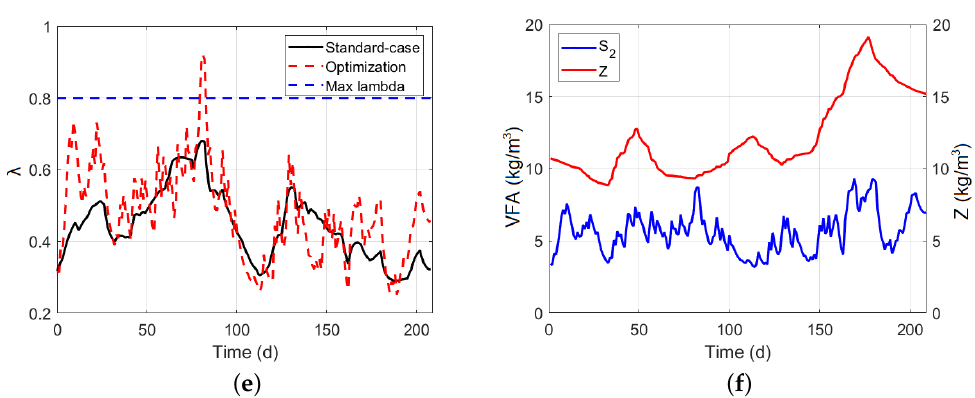
Figure 8. MPC controller without restrictions. ( a ) Volume of CH 4 ; ( b ) dilution rate D; ( c ) value of pH; ( d ) dynamic of VFA; ( e ) values of λ ; ( f ) dynamics of S 2 and Z.